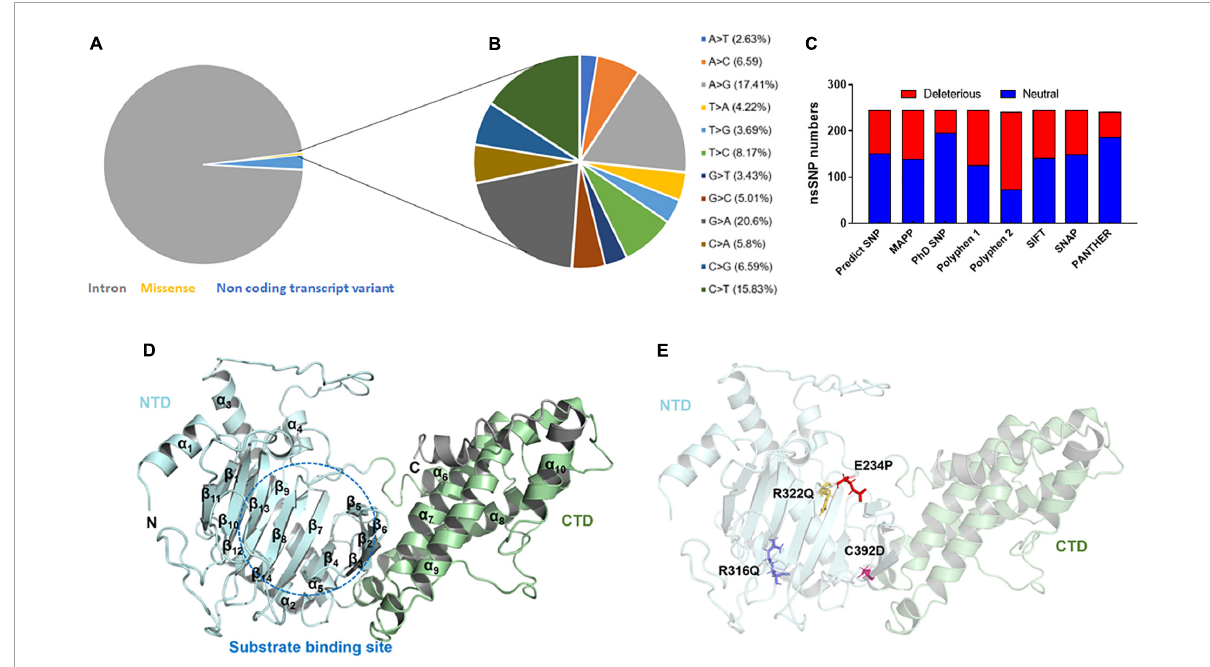
FIGURE1 Mutational profile and tertiary structure of FTO protein. (A) Types of mutations, (B) total transition and transversion of non-synonymous missense mutations, (C) number of deleterious and neutral non-synonymous SNP, (D) tertiary structure of full length FTO protein showed different domains and (E) tertiary structure of protein showed various mutations. Protein structures were depicted in cartoon mode and substrate binding site was highlighted in blue dotted circle. Helices and sheets were labeled in α and β symbols. Different MTs such as E234P, R316Q, R322Q, and C392D were shown in red, blue, mustard and magenta color sticks, respectively. NTD, N-terminal domain; CTD, C-terminal